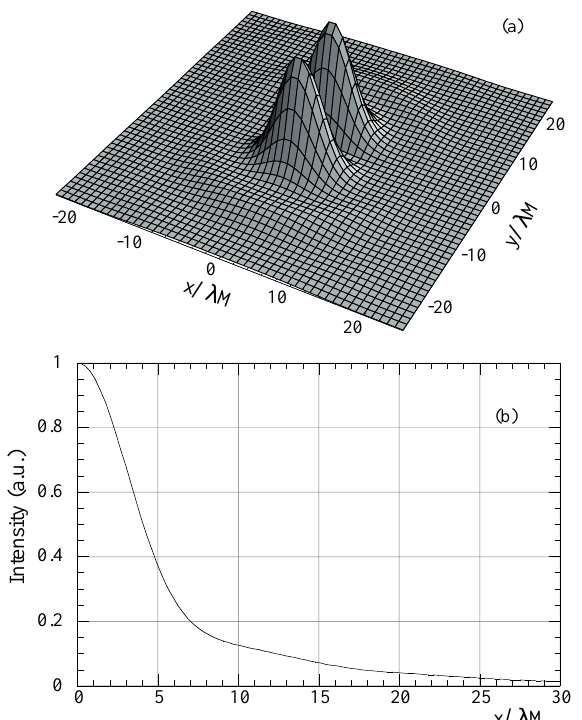
FIG. 7. 3D plot of the radial SPF for the (cid:121) -polarized compo- nent (a) and its projection on the (cid:120) axis (b) for 0.5% cutoff level. The vertical scale in the 3D plot is the intensity in arbi- trary units. u (cid:108)(cid:101)(cid:110)(cid:115) (cid:173) (cid:48)(cid:46)(cid:49) and bg (cid:173) (cid:49)(cid:48)(cid:48)(cid:48) .